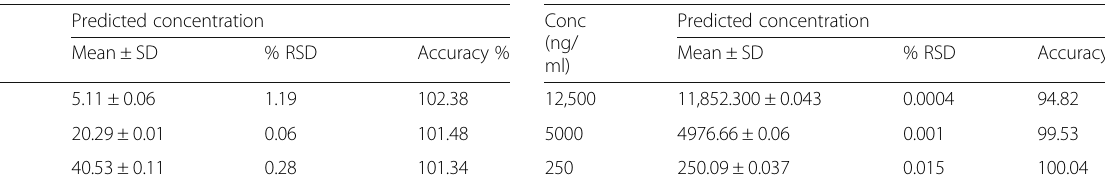
Table 1 Accuracy data for the developed analytical method for naringenin